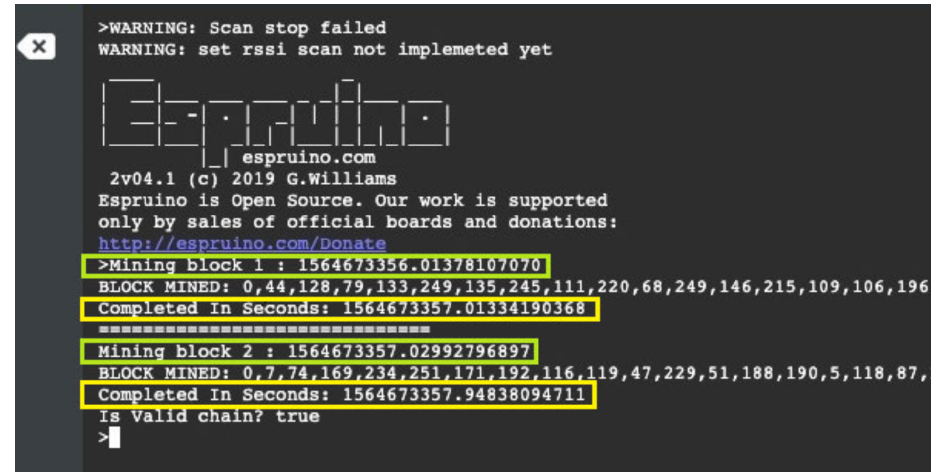
Figure 13. Result of block mining in Espruino